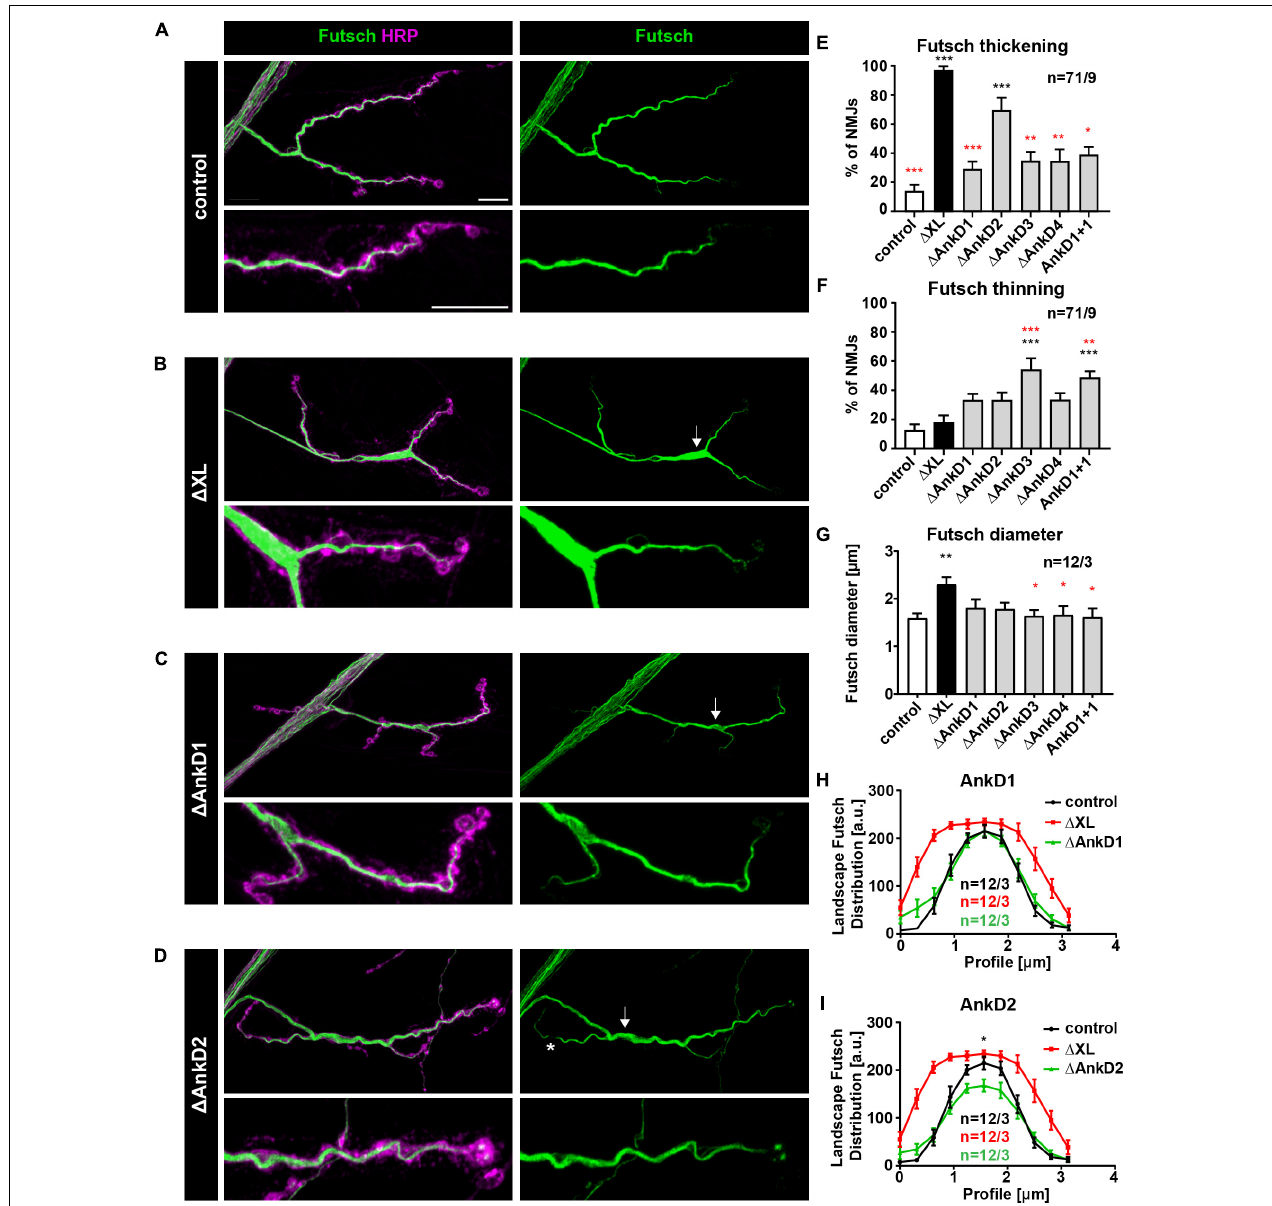
FIGURE 7 | Analysis of ARD-dependent control of synaptic microtubule organization. (A–D) Analysis of the distribution of the microtubule marker Futsch/MAP1B (green) at muscle 4 NMJs. In control animals ( P[ank2_wt] /+; ank2 (cid:49) XL /ank2 (cid:49) XL ) Futsch marks the filamentous organization of presynaptic microtubules (A) . In the absence of Ank2-XL Futsch accumulates within synaptic boutons of central areas of the NMJ (thickening, arrow) (B) . Deletion mutations of the ARD cause only minor alterations of Futsch organization, thickenings (arrow) and thinnings (asterisks) (C,D) . (E) Quantification of aberrant thickenings of the Futsch staining ( n = 71 muscle 4 NMJs, nine animals). (F) Quantification of aberrant thinnings of the Futsch staining ( n = 71 muscle 4 NMJs, nine animals). (G) Quantification of the maximal Futsch diameter within NMJs ( n = 12 muscle 4 NMJs, three animals). (H,I) Quantification of the Futsch profile within boutons of controls (black trace), ank2 (cid:49) XL (red trace), (cid:49) AnkD1 (green trace in H ) and (cid:49) AnkD2 (green trace in G ) mutants ( n = 12 muscle 4 NMJs, three animals). Scale bars in (A) apply to (A–D) and represent 10 µ m. Error bars indicate SEM; ∗ p < 0.05, ∗∗ p < 0.01, ∗∗∗ p < 0.001 (ANOVA); black asterisks represent comparisons to controls; red asterisks represent comparisons to ank2 (cid:49) XL